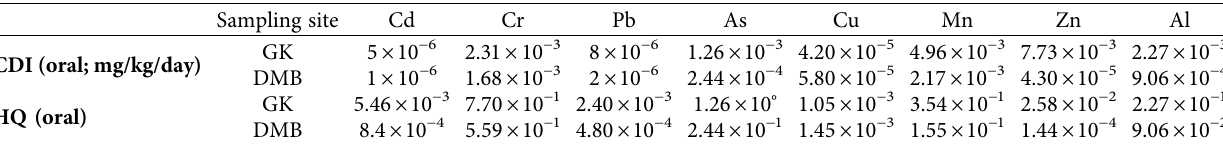
“Poor” indicates the status of the WQI in the CKDu prevalent area. “C” indicates the grade obtained for the WQI in the CKDu prevalent area. “Good” indicates the status of the WQI in the non-CKDu prevalent area. “B” indicates the grade obtained for the WQI in the non-CKDu prevalent area. These are based on Table 2. Table 6: The calculated chronic daily intake (CDI) and hazard quotient (HQ) values of drinking water samples collected from CKDu prevalent and non-CKDu prevalent areas, Sri Lanka.